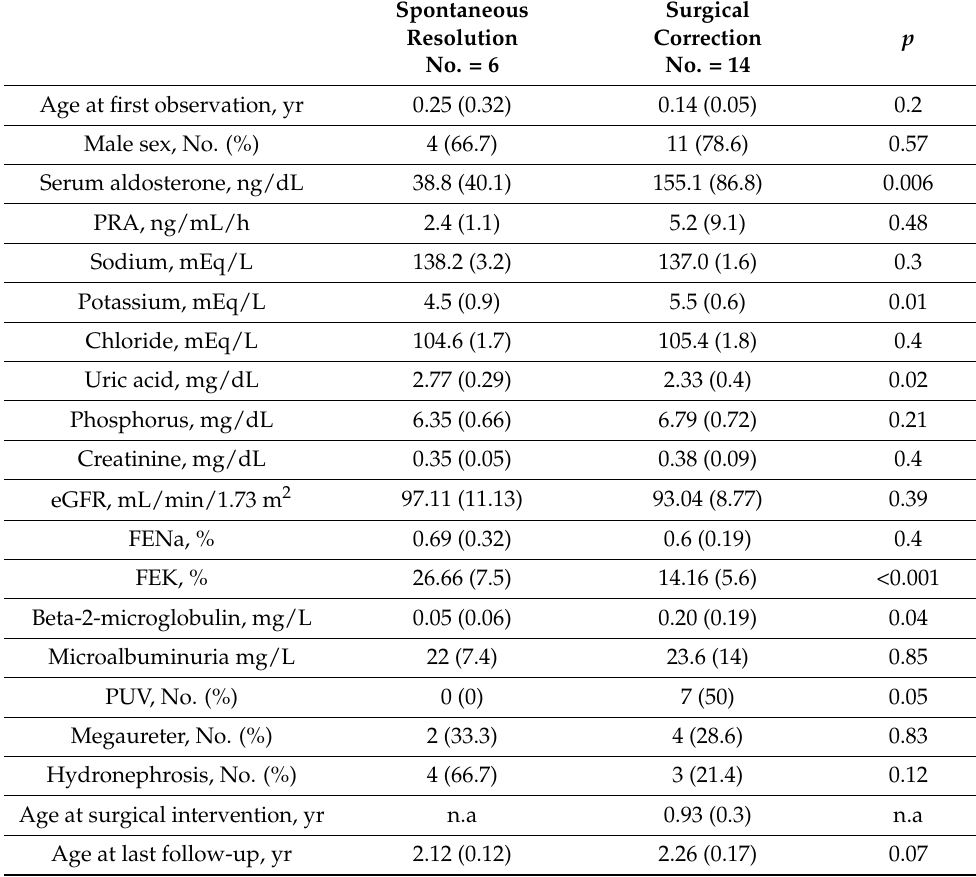
Table 1. Clinical and biochemical characteristics of patients presenting or not presenting spontaneous obstructive CAKUT resolution. For continuous variables, means ± SDS are shown. Abbreviations: FENa, fractional excretion of Na; eGFR, estimated glomerular filtration rate; FEK, fractional excretion of K; PRA, plasma renin activity; PUV, posterior urethral valves. Spontaneous Surgical Resolution Correction No. = 6 No. = 14 Age at first observation, yr 0.25